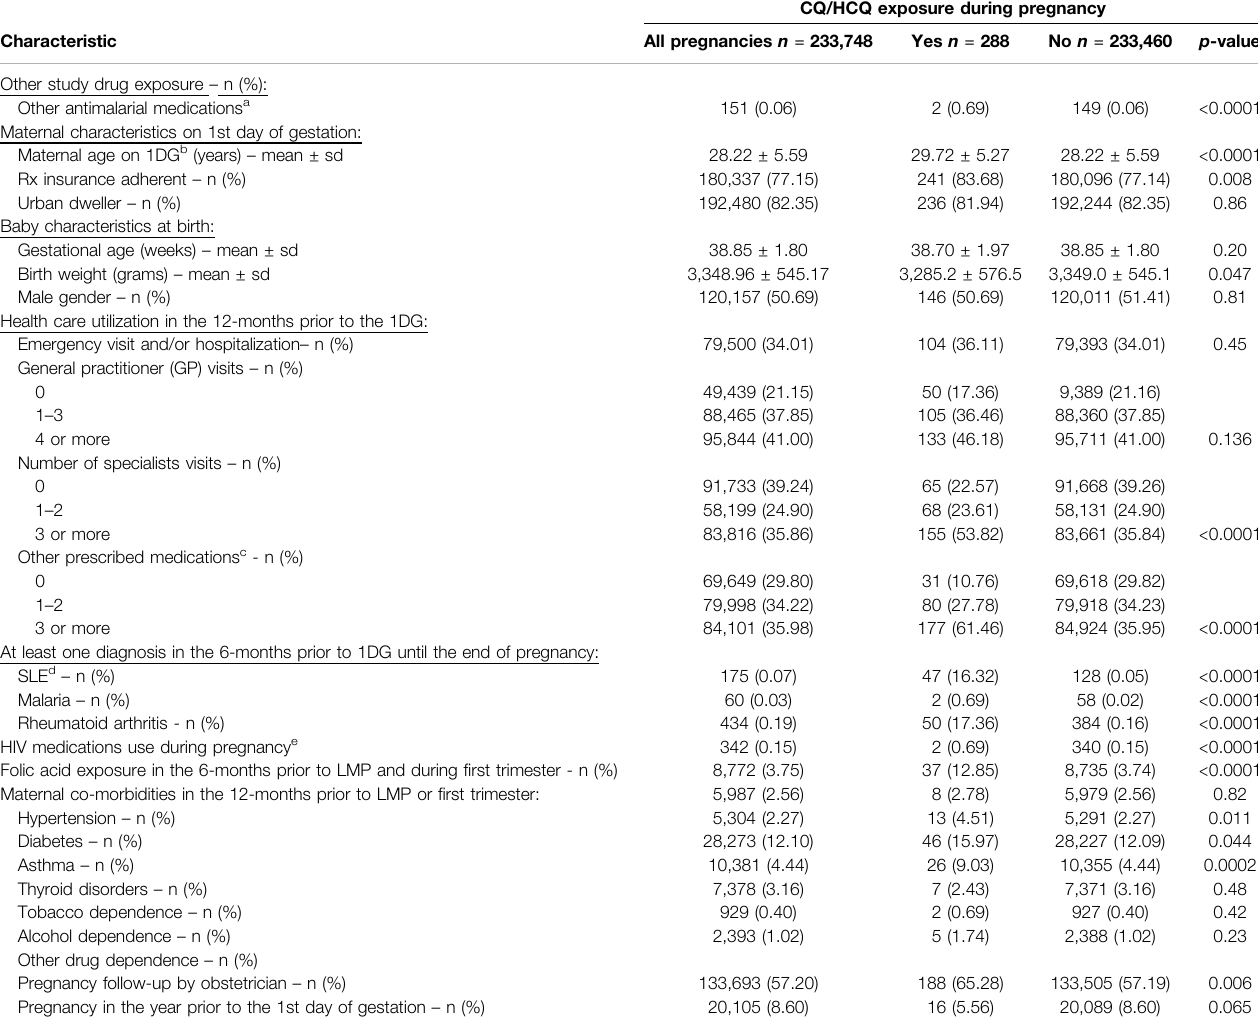
TABLE 1 | Characteristics of the pregnancies based on chloroquine (CQ)/hydroxychloroquine (HCQ) exposure status.